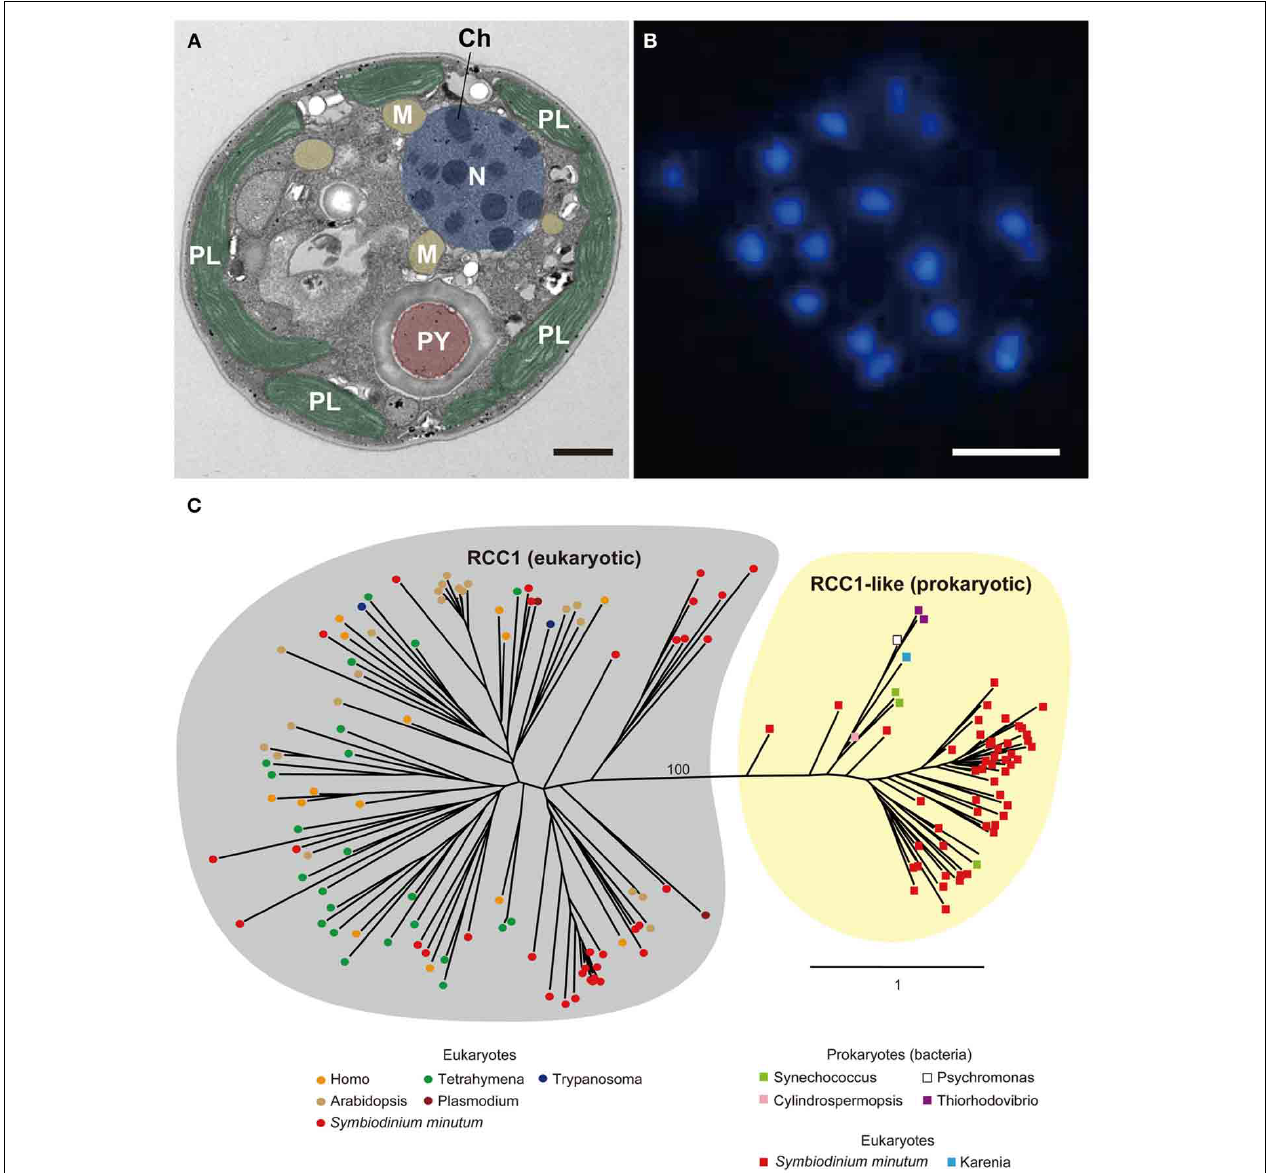
FIGURE 9 | (A) Electron micrograph showing permanently condensed chromosomes (Ch) of Symbiodinium minutum . The nucleus (N) is shown in purple, plastids (PL) in green, mitochondria (M) in orange, and pyrenoid (PY) in brown. Scale bar, 1 μ m. (B) DAPI staining of the nucleus showing permanently condensed chromosomes of S. minutum. Scale bar, 1 μ m. (C) RCC1 proteins are eukaryotic proteins that bind to